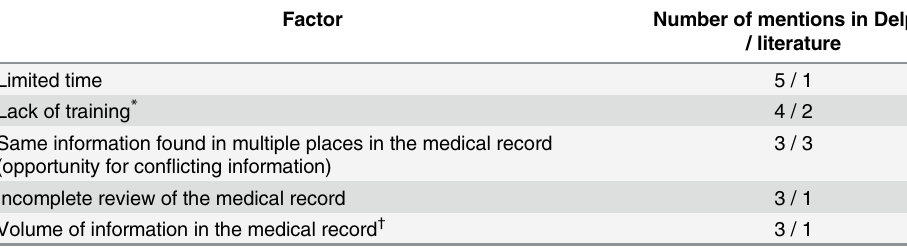
Table 2. Factors identified in Delphi Round 1 that were not in the literature top